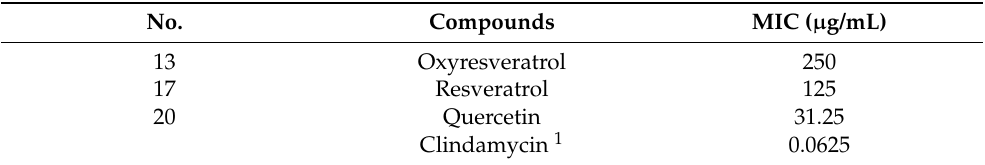
Table 2. Minimum inhibition concentration (MIC) of active compounds 13, 17, and 20 against C. acnes KCTC 3314.